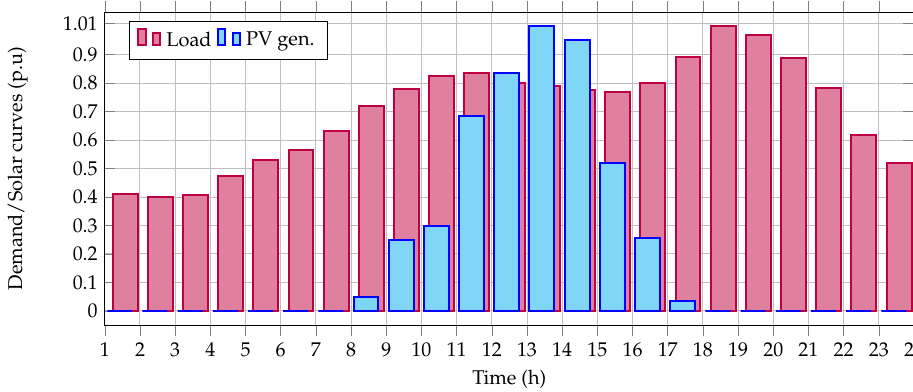
Figure 4. Average demand and generation curves in Medellín,